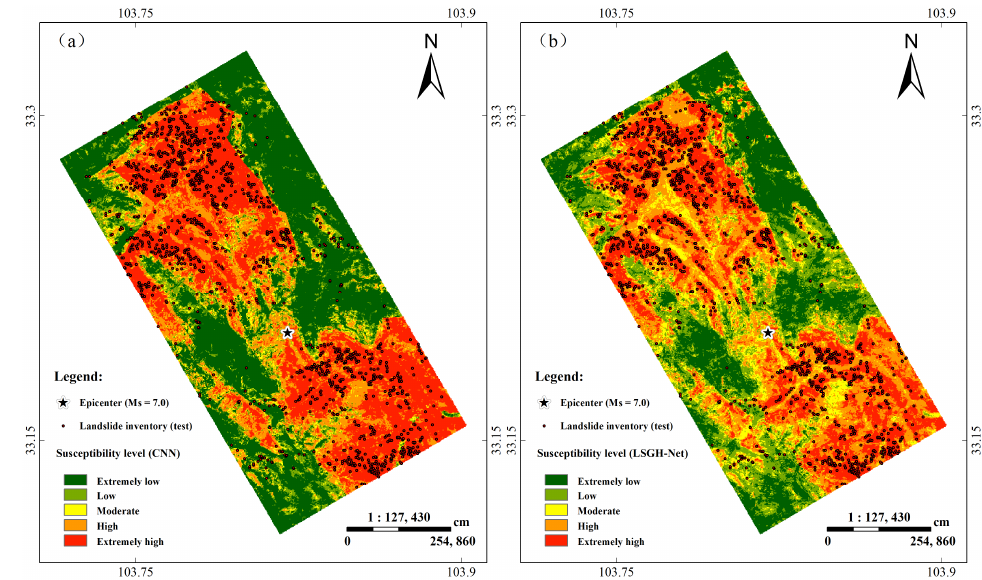
Figure 9. The results of LSM ( a ) CNN ( b ) LSGH-Net.